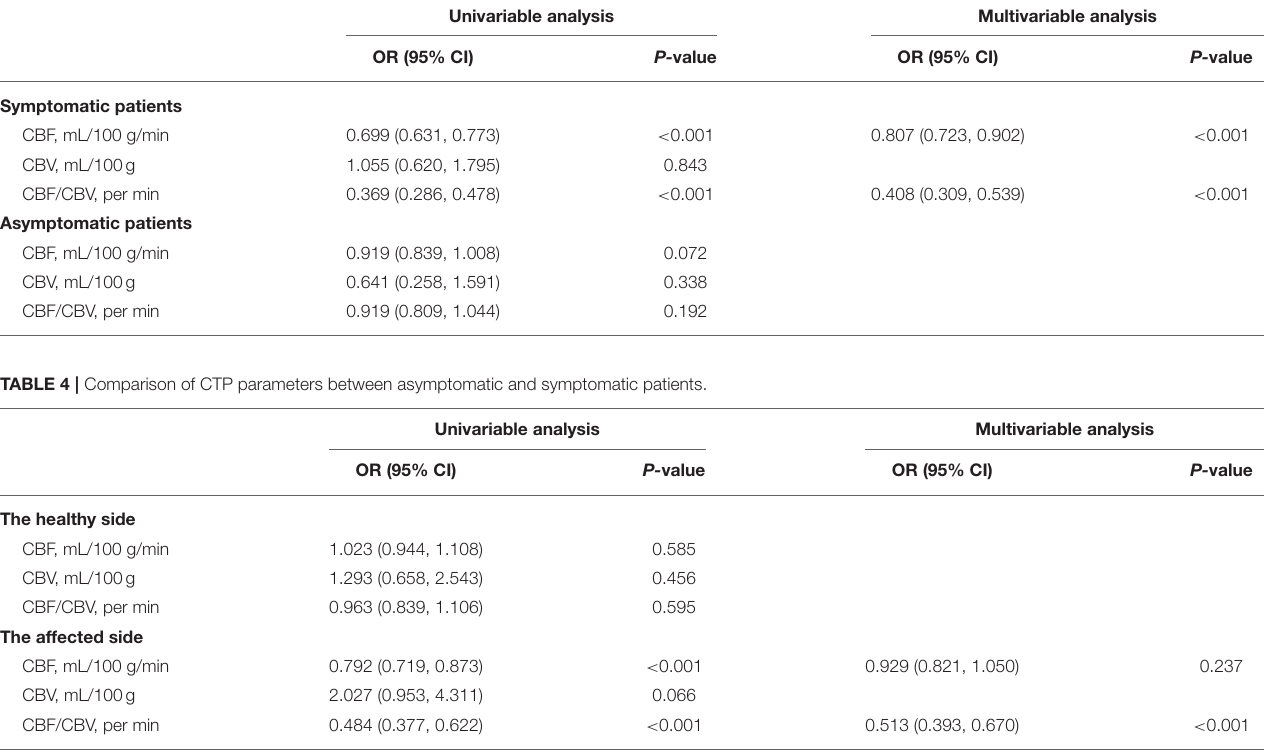
TABLE 3 | Comparison of computed tomography perfusion (CTP) parameters between healthy and affected sides.